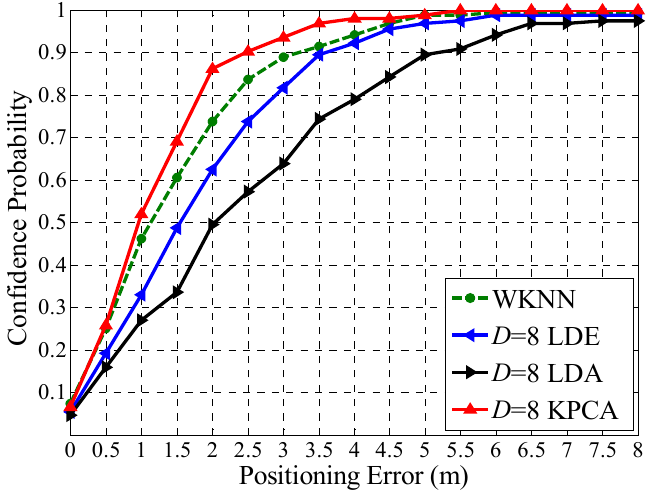
Figure 14. Positioning accuracies comparison in the noisy circumstance in S1